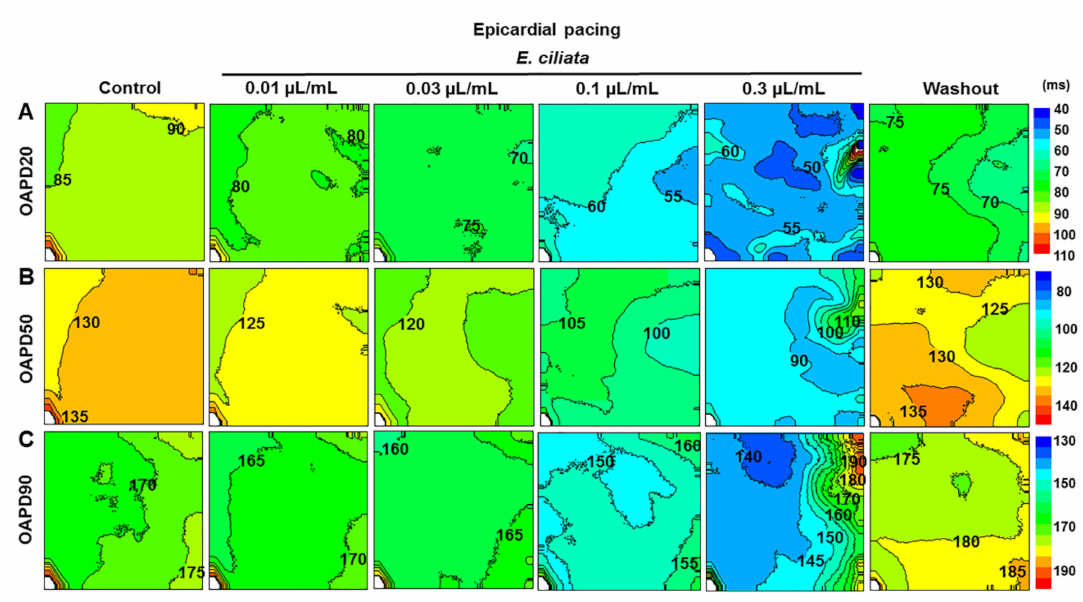
Figure 8. Changes in OAP duration maps induced by E. ciliata during epicardial stimulation. ( A ) OAPD20, ( B ) OAPD50, and ( C ) OAPD90 maps in the control and after applying 0.01, 0.03, 0.1, and 0.3 µ L / mL concentrations of the E. ciliata , followed by a washout period. OAPD20, OAPD50, and OAPD90 maps calculated at 20%, 50%, and 90% of repolarization, respectively. The interval between isochrones is 5 ms. Other notations are the same as in Figure